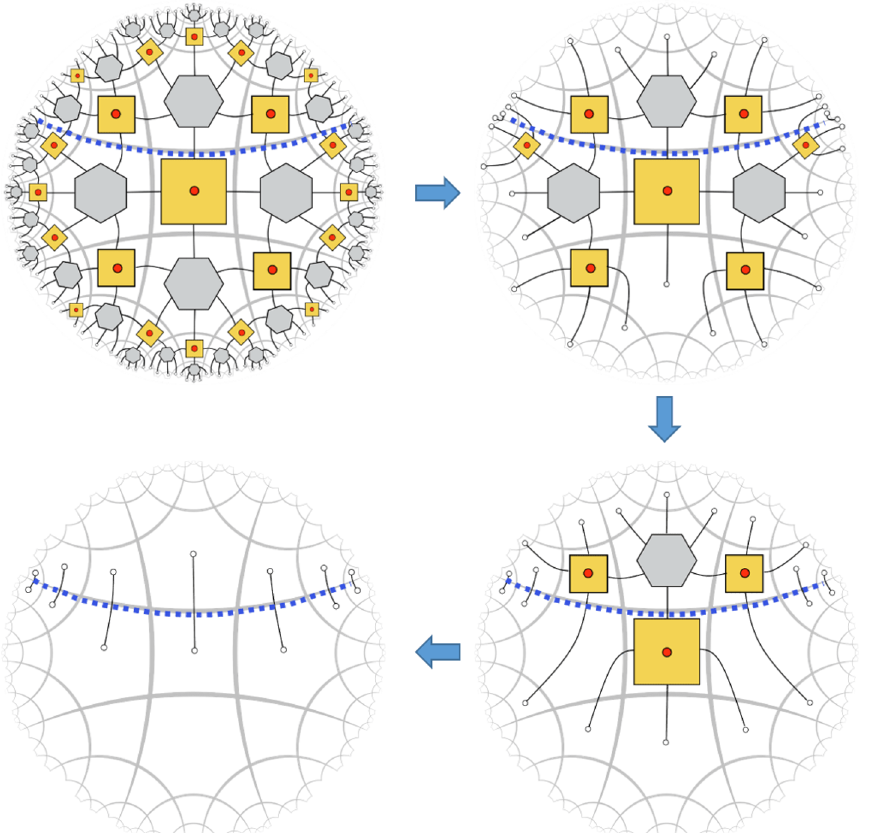
Figure 27. Distilling entanglement across the bipartitions using local moves.